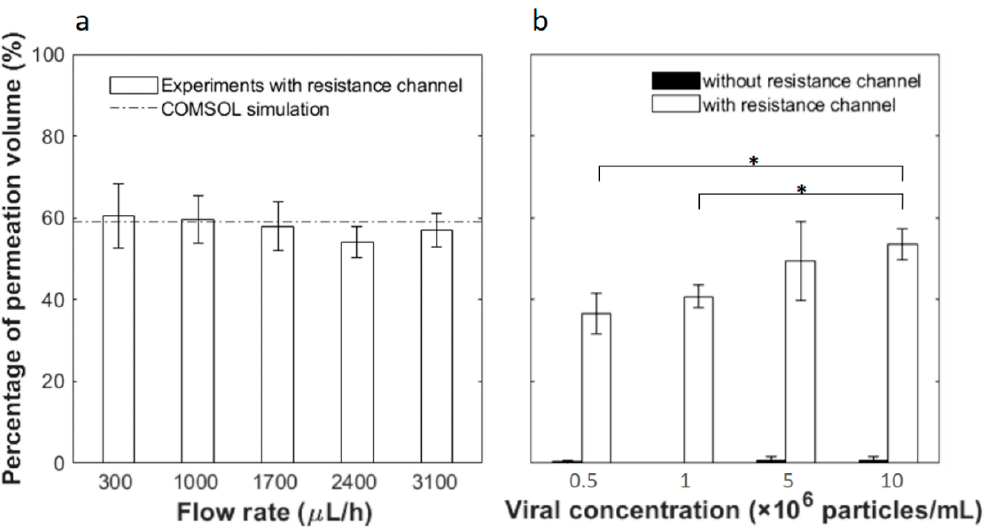
Figure 4. Fluid fraction permeating through the membrane as a function of ( a ) different flow rates and ( b ) inlet viral concentrations. In ( b ) the white bars are results from filtration devices connected with 65-mm-length resistance channels, while black bars are results from devices without. Error bars represent the standard deviation from at least 3 independent tests under the same condition. * indicates statistical difference based on two-tailed Student’s t-test at a 95% confidence interval.